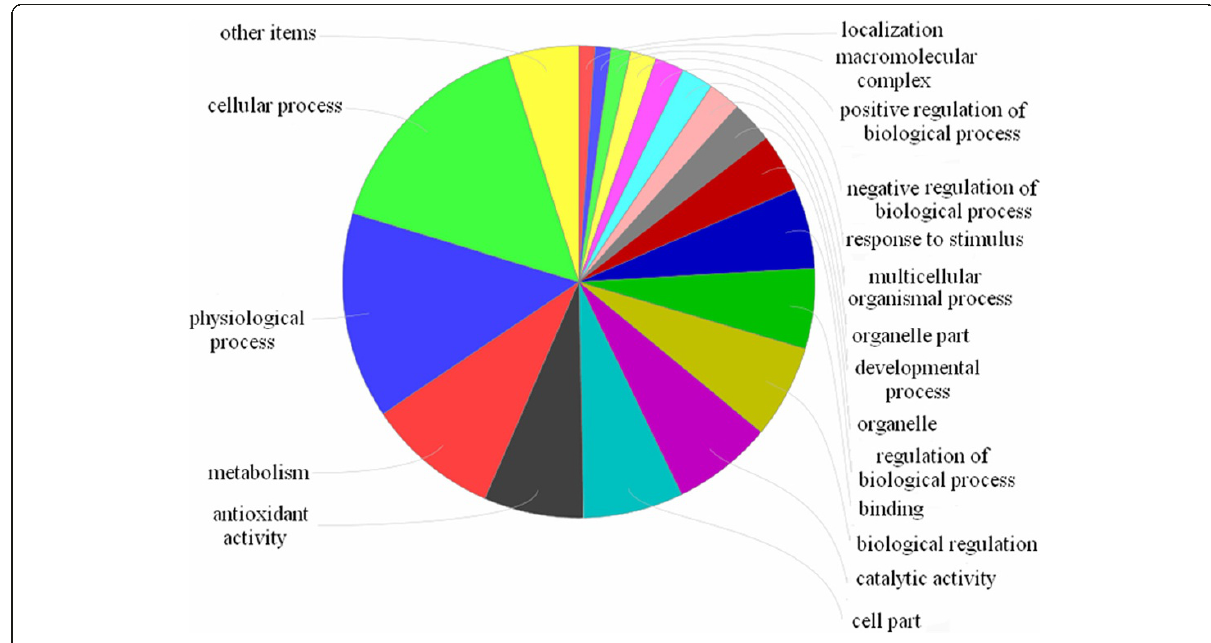
Figure 4 Ontology of differentially expressed